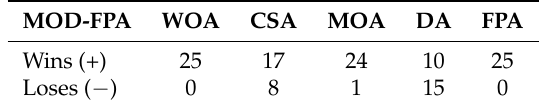
Table 14. Sing test for pairwise comparisons with a level of significance ∝ =